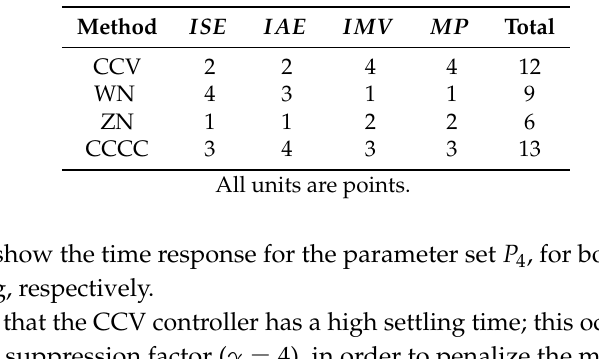
Table 8. Scores. Set-point tracking for the set P 4